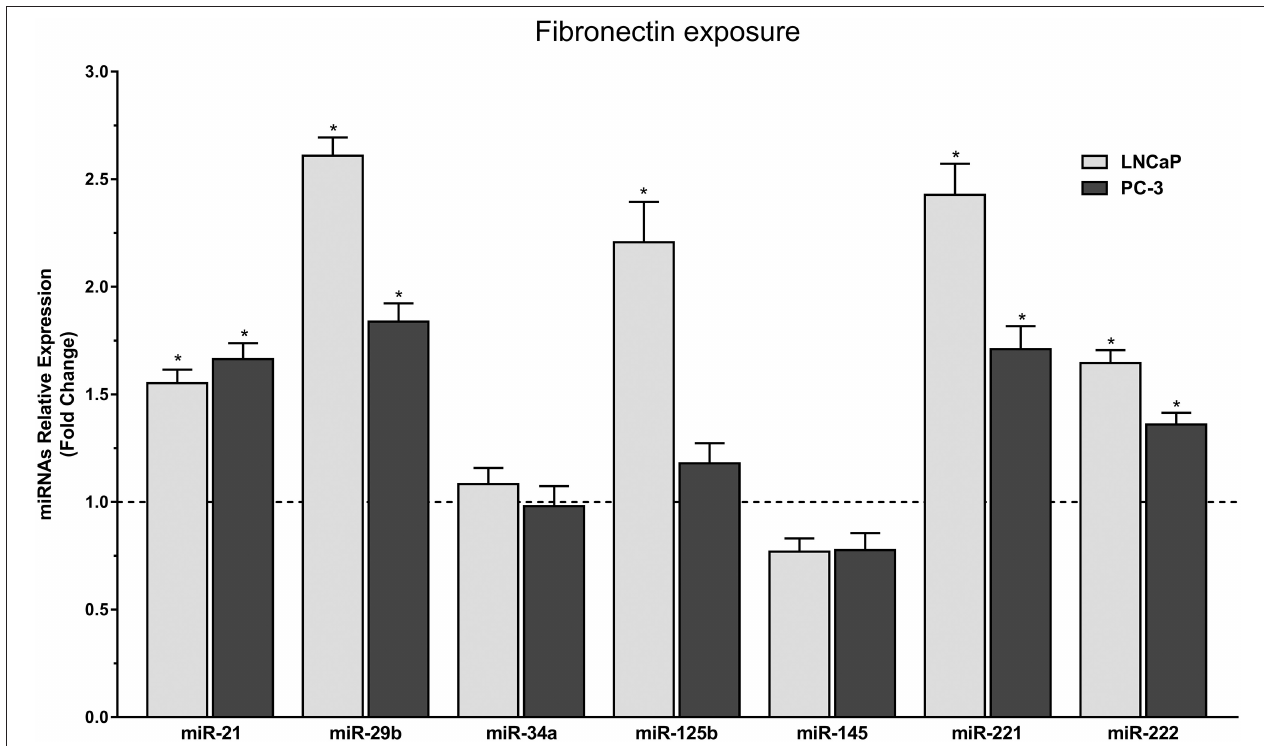
FIGURE 1 | Relative expression of miRNAs after FN exposure in LNCaP and PC-3 cells (Fold Change from unexposed cells from each cell line). Light grey bars represent the miRNA levels of LNCaP cells exposed to FN, and dark grey bars represent the PC-3 cells. The line represents the value of non-exposed LNCaP and PC-3 cells. Values are expressed by mean ± SEM (Standard error of the mean * p < 0.05 between cells exposed and non-exposed in the same cell line).